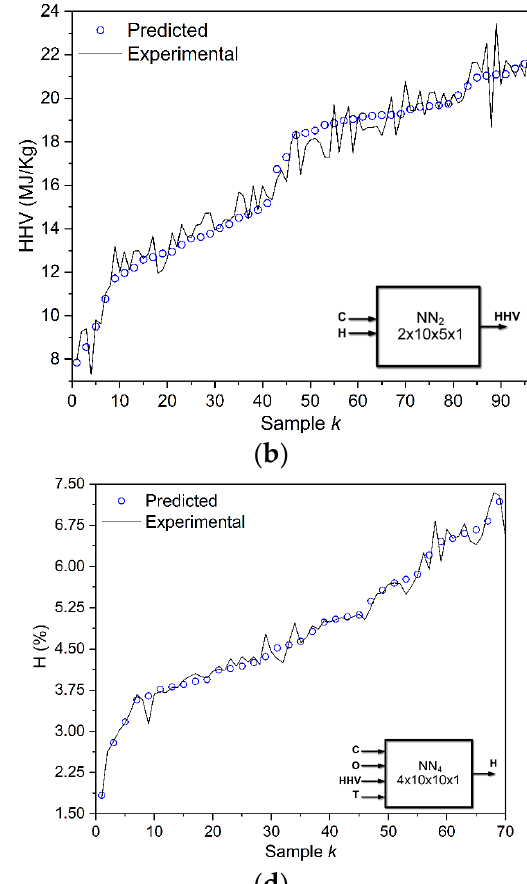
Energies 2021 , 14 , 3000 11 of 15 tion of the proposed ANN models. From the results, it is made apparent that the devel-